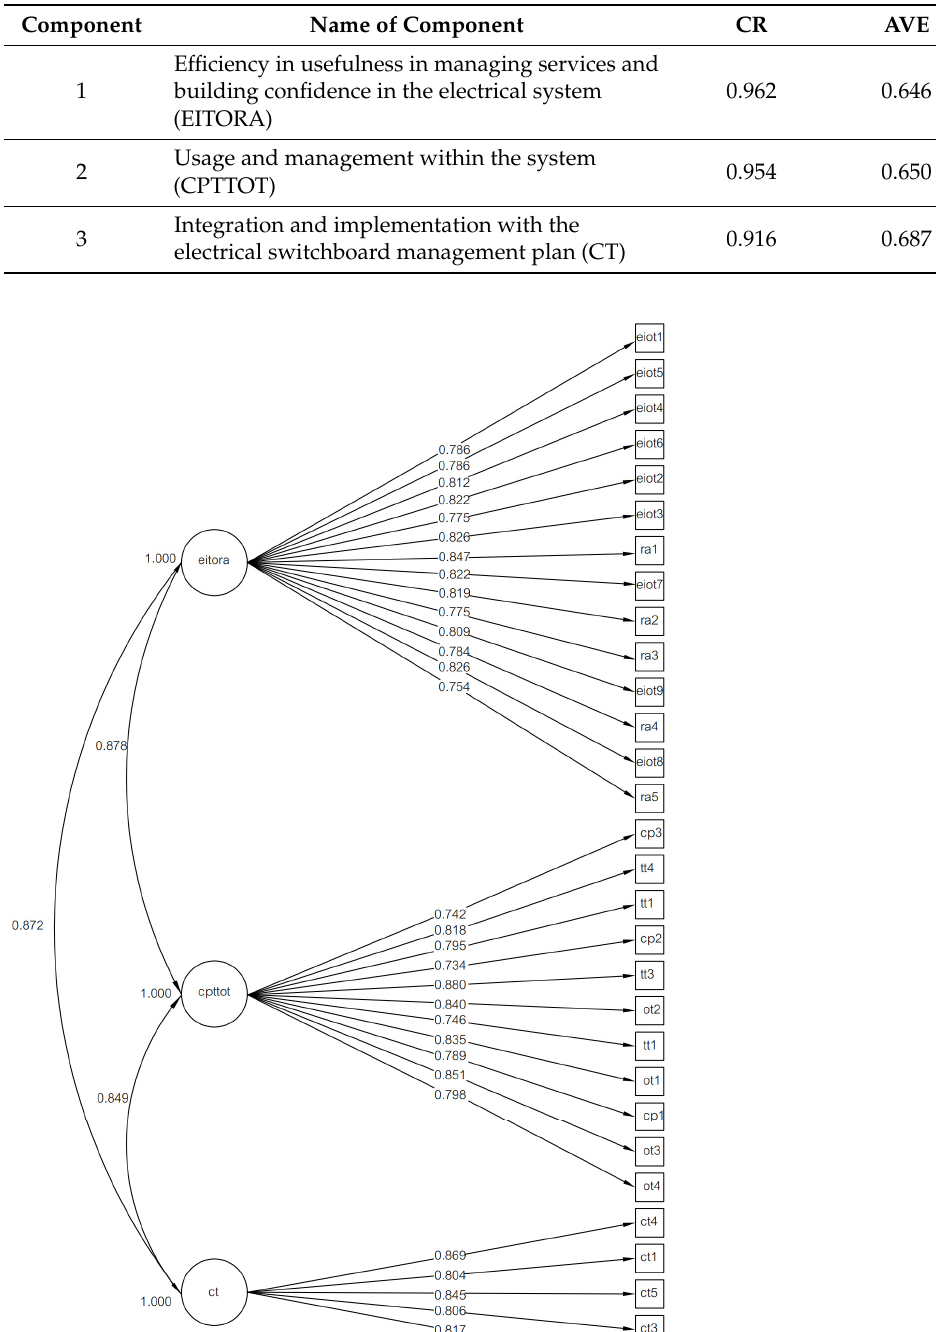
Table 5. The inspection of the discriminant validity and construct validity.